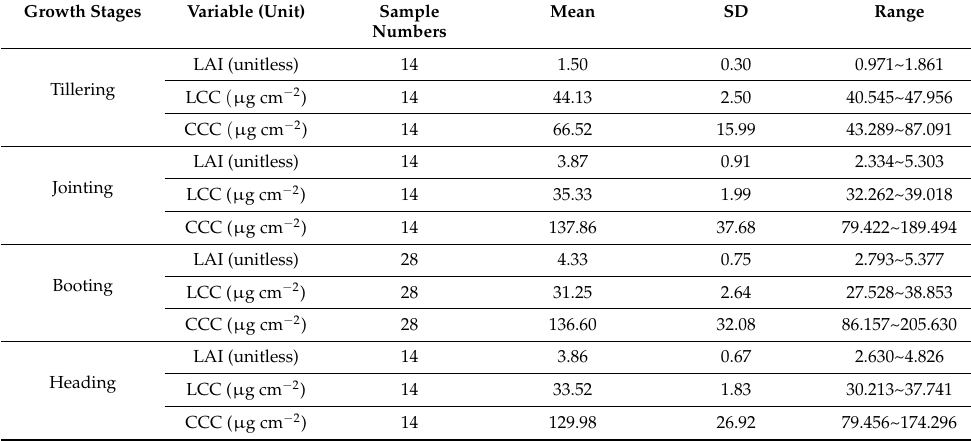
Table 2. Characteristics of observed leaf area index (LAI), leaf chlorophyll content (LCC), and canopy chlorophyll content